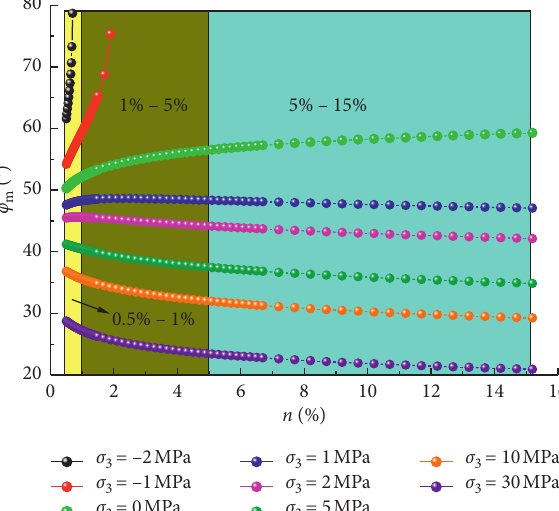
Figure 8: E m varies with the porosity.